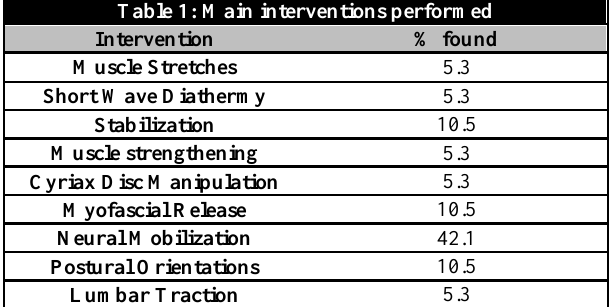
Table 1: Main interventions performed Intervention